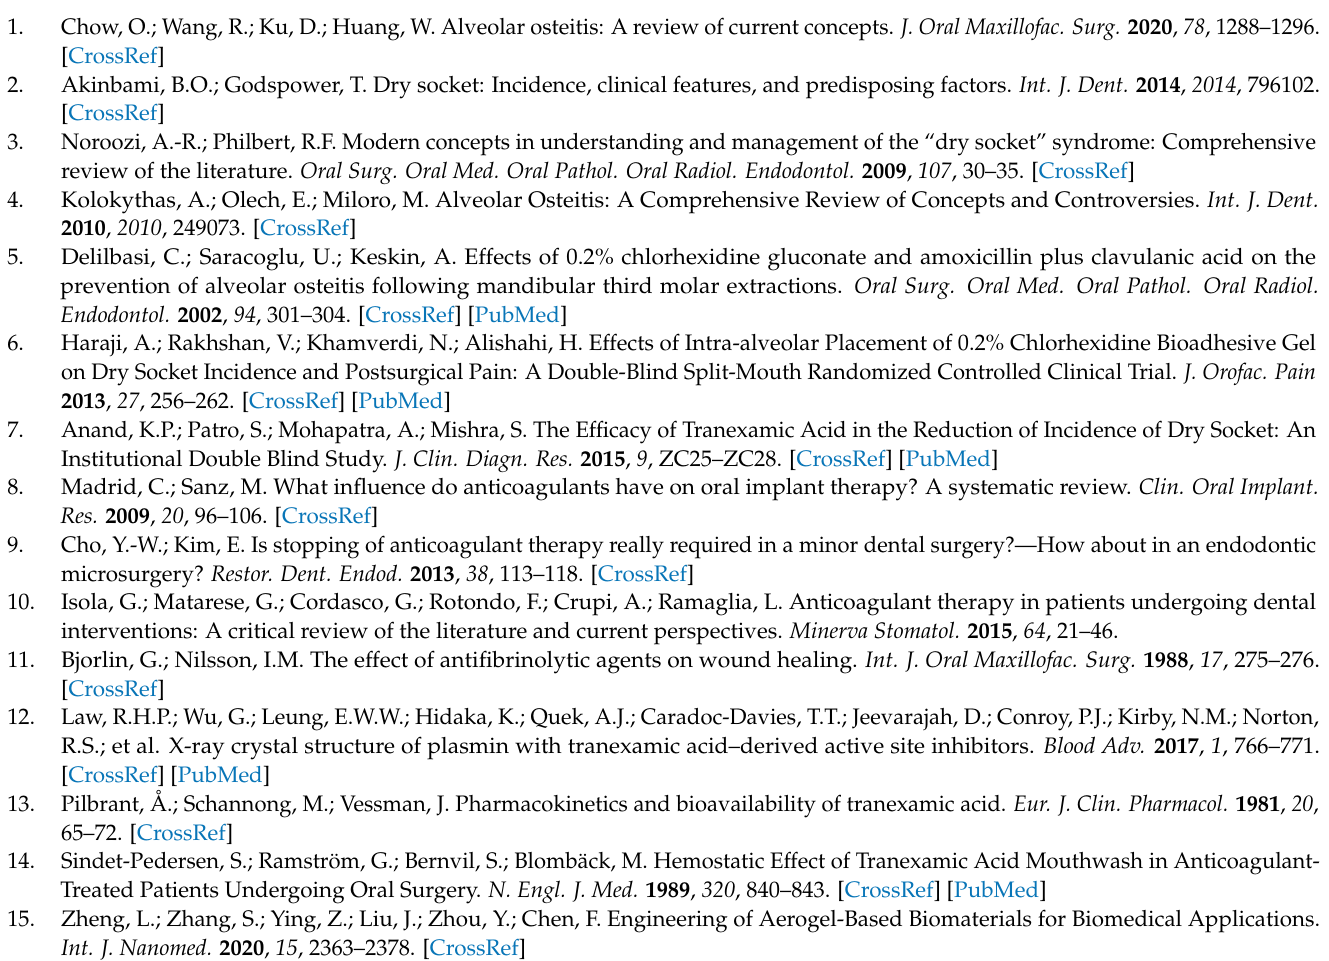
A 3 H 1 aerogel. Table S1: Kinetics parameters of the prepared alginate/nano-hydroxyapatite composite aerogels loaded with tranexamic